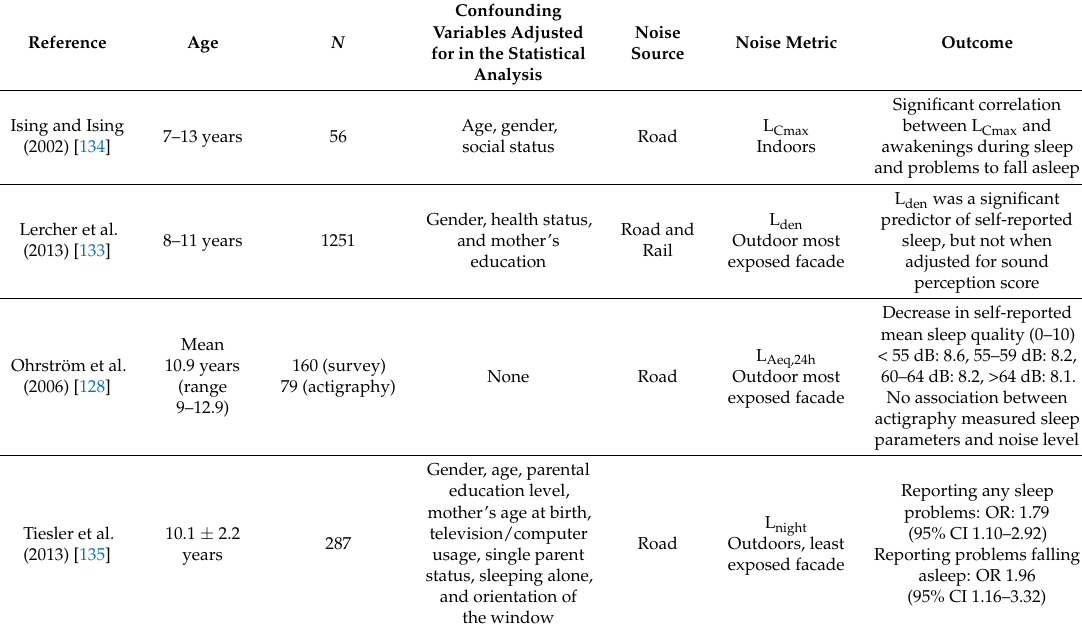
Table 12. Characteristics of studies that evaluated sleep in